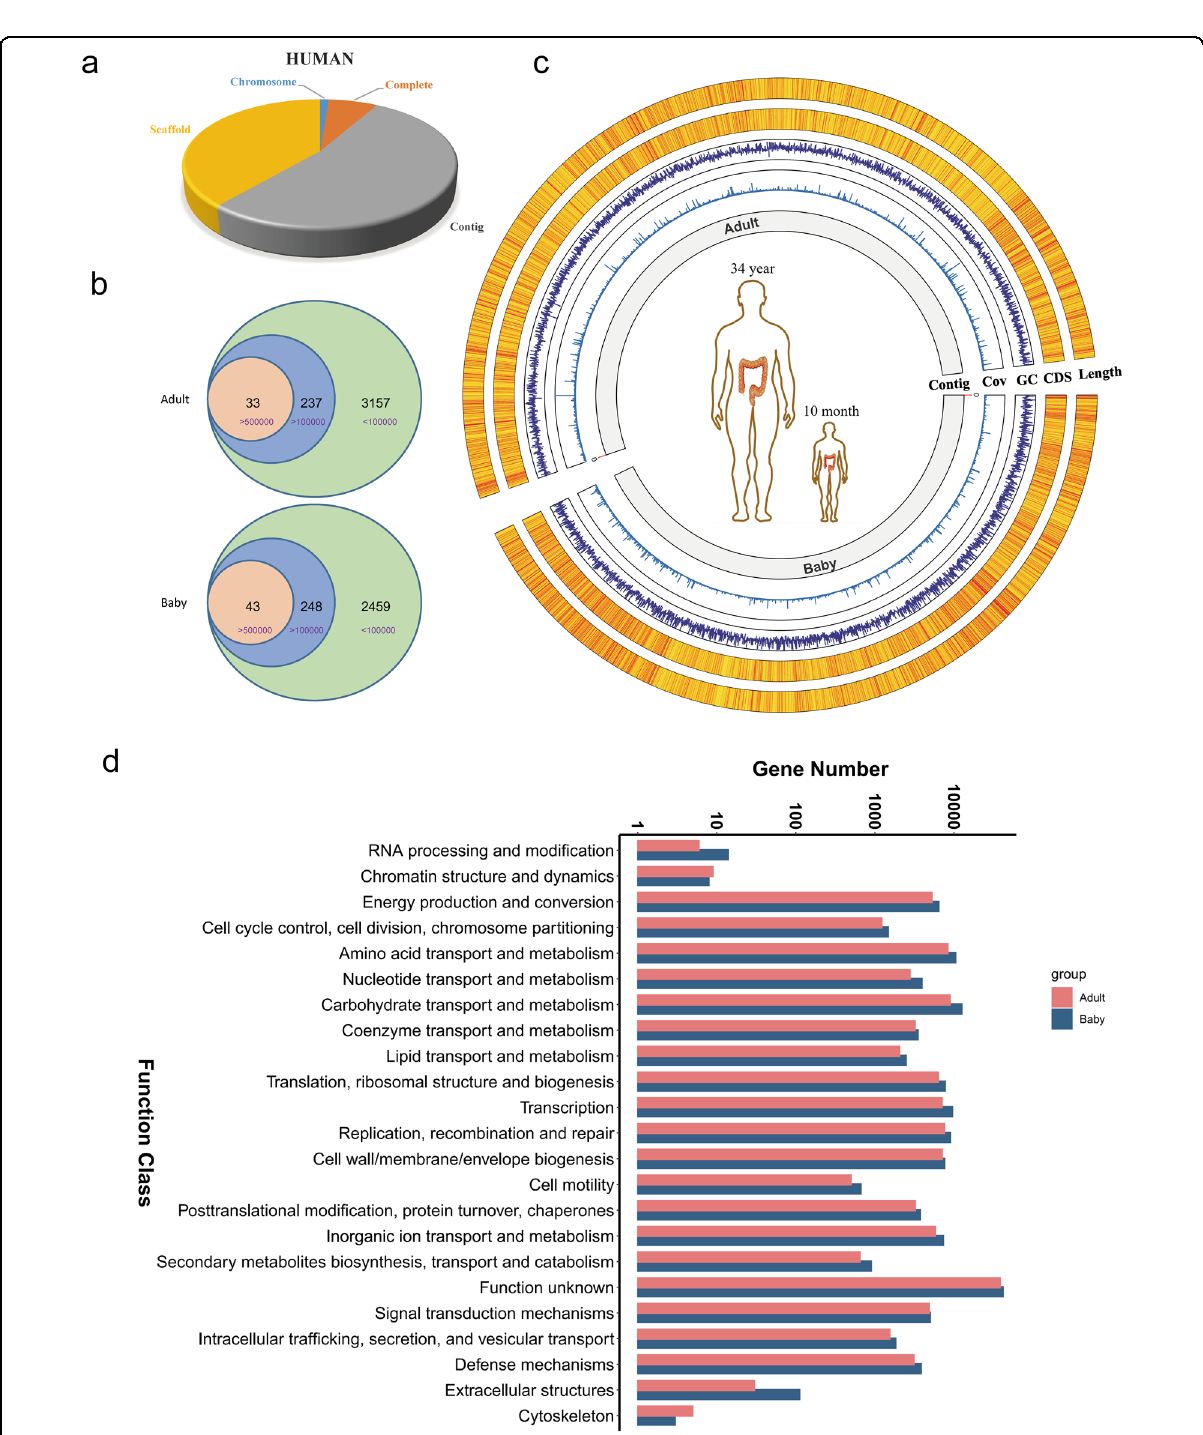
Fig. 1 The characteristics of the two samples. a Pie chart comprising four classes of human bacteria sequence data in the NCBI databases: chromosome, complete, scaffold, and Contig. b Numbers of contigs with different lengthes acquired from the two samples, relative to the adult sample (up) and the baby sample (down). c The whole characteristics of the two samples. The corresponding contig length and CDS number were depicted in the fi rst outer layer and the second outer layer, respectively; the GC content was depicted in the third outer layer; the contig number and the coverage were depicted in the fi rst inner layer and the second inner layer, respectively. d Function analyses of all the CDSs of the two